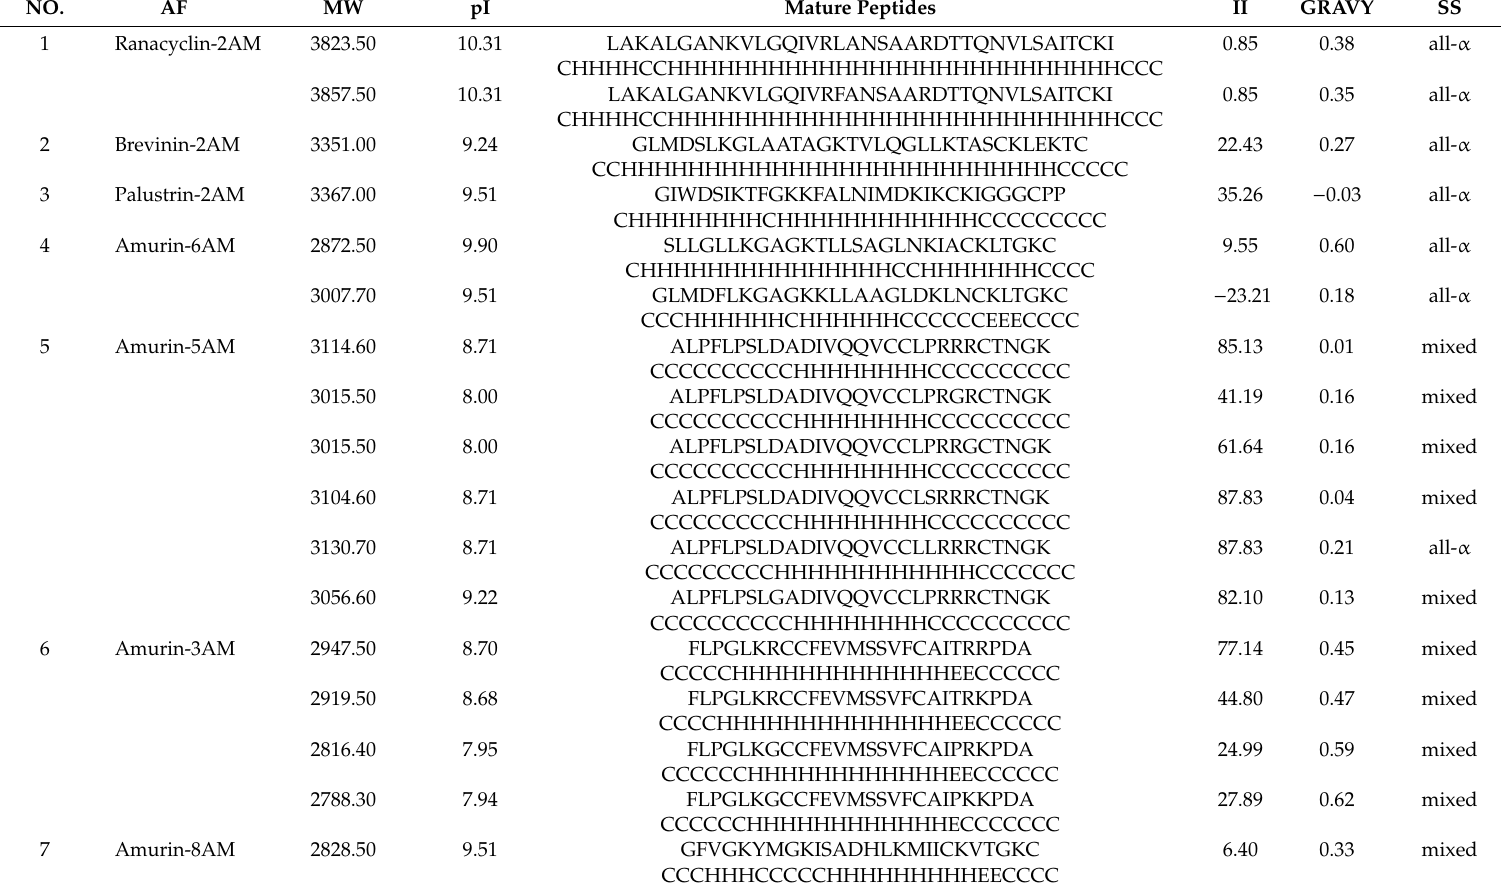
Table A1. The physicochemical and structural properties of mature peptides from R. amurensis